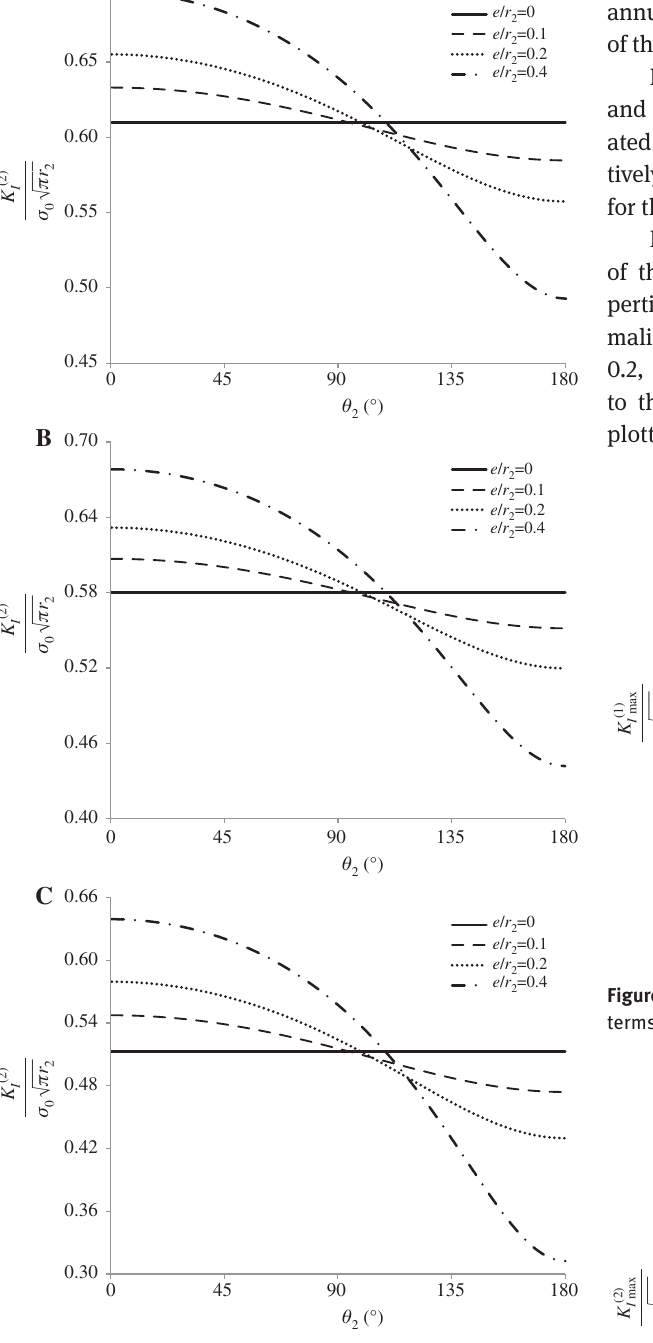
= 0.2, and (C) r / r 1 2